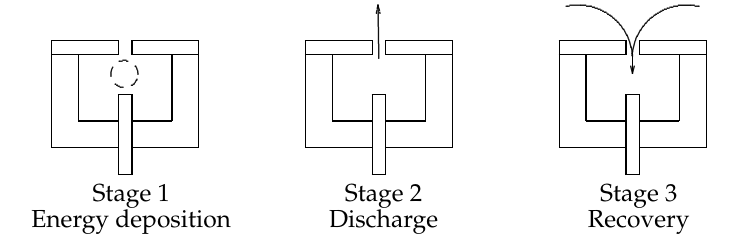
Figure 1. SparkJet operation.